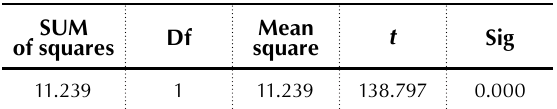
Table 7. T -value and the level of awareness among the hotels